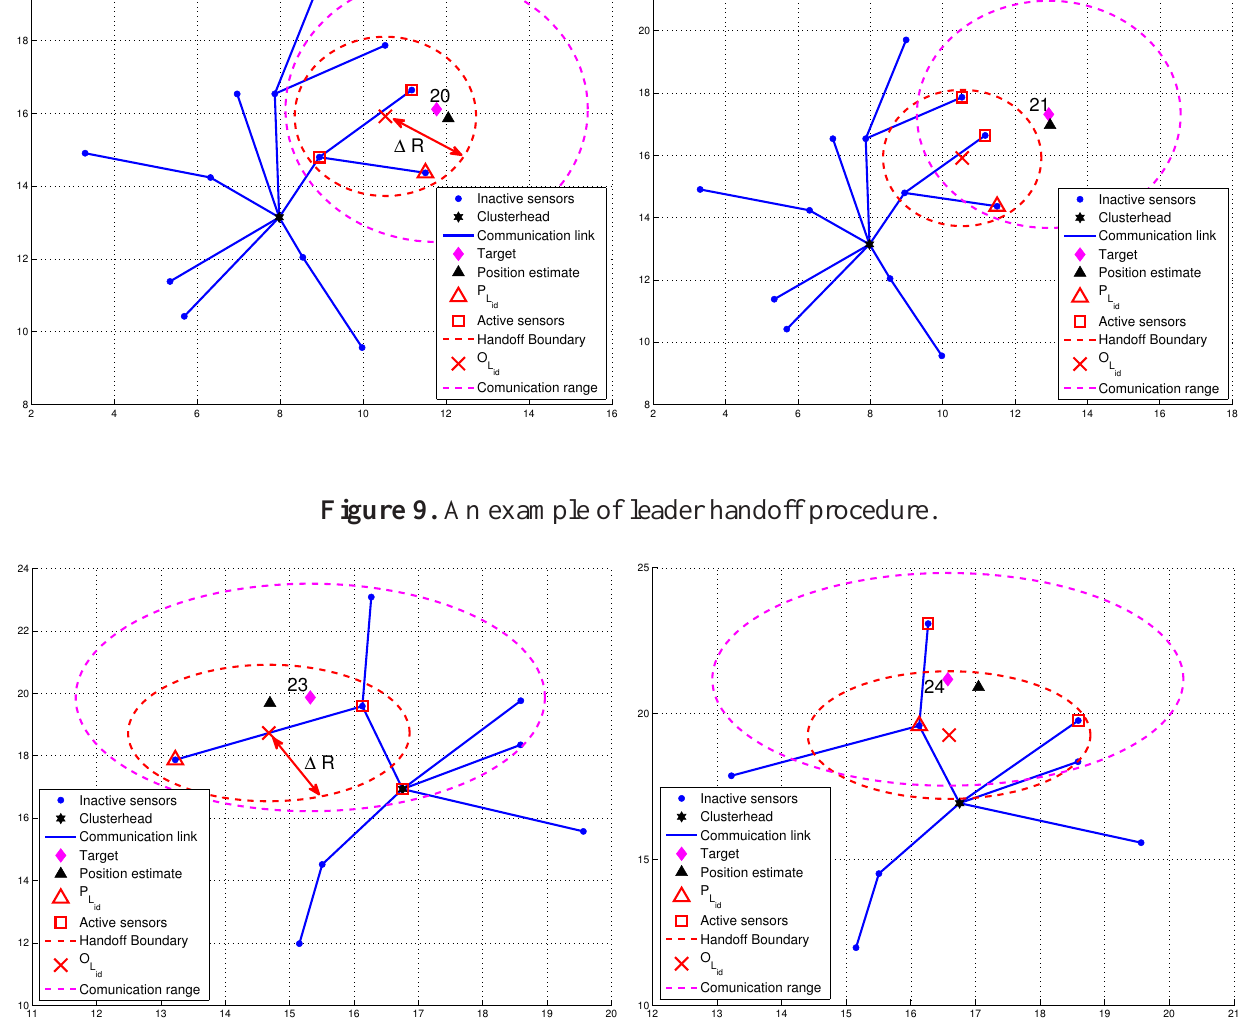
Figure 8. An example of adaptively updating the sub-cluster members with